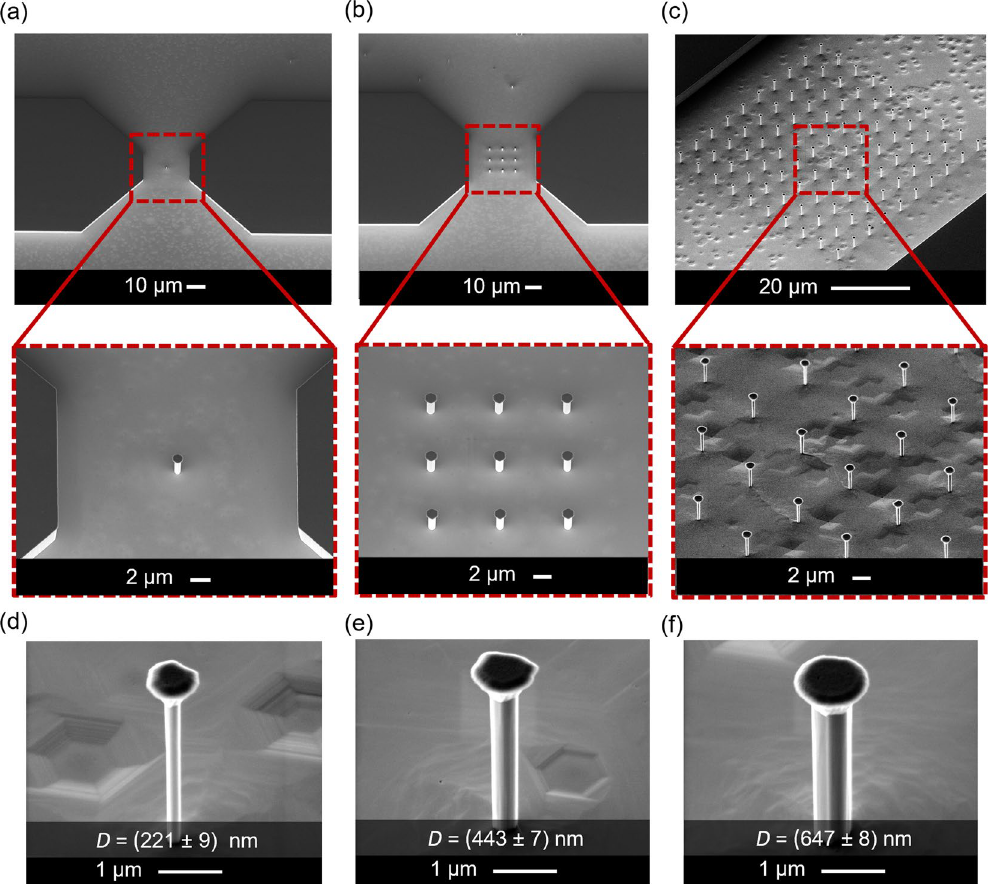
Figure 2. Bird-view SEM images of vertically aligned n-p-n GaN nanowire (NW) arrays after ICP-DRIE and wet chemical etching with NW numbers of ( a ) 1, ( b ) 9, and ( c ) 100. Varied wire diameters ( D ) of ( d ) (221 ± 9) nm, ( e ) (443 ± 7) nm, and (f) (647 ± 8) nm were obtained originating from different pattern sizes of the used Cr etching